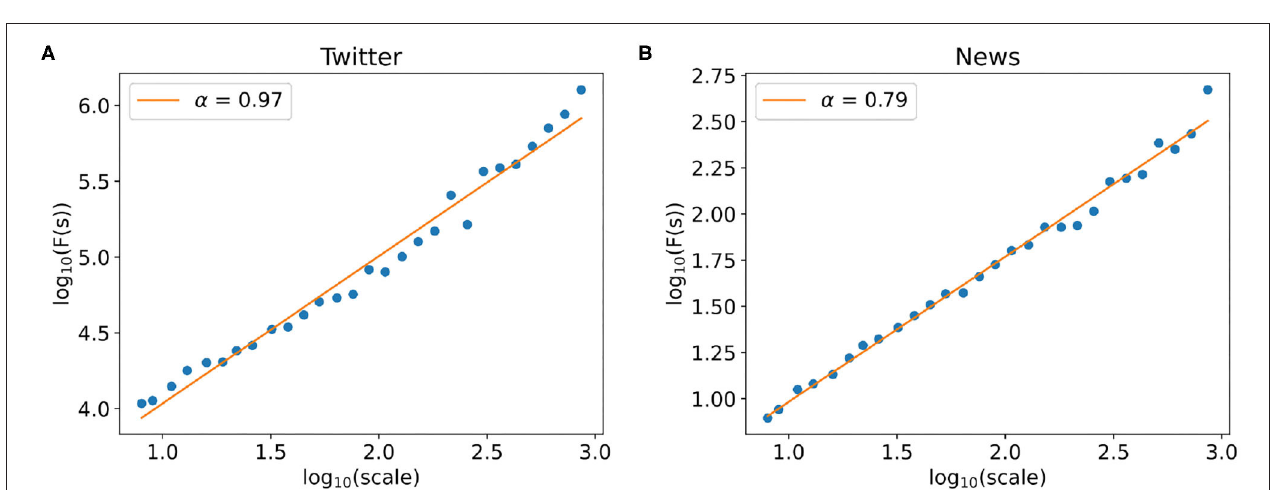
FIGURE 7 | TF-IDF vs. sentence false rate. (A–D) Comparison between top words in COVID-19 tweets, false rumors, and non-false rumors. (E) Comparison between frequent words in false rumors and trending Twitter hashtags. Color and size of the bubble indicate word source and frequency.